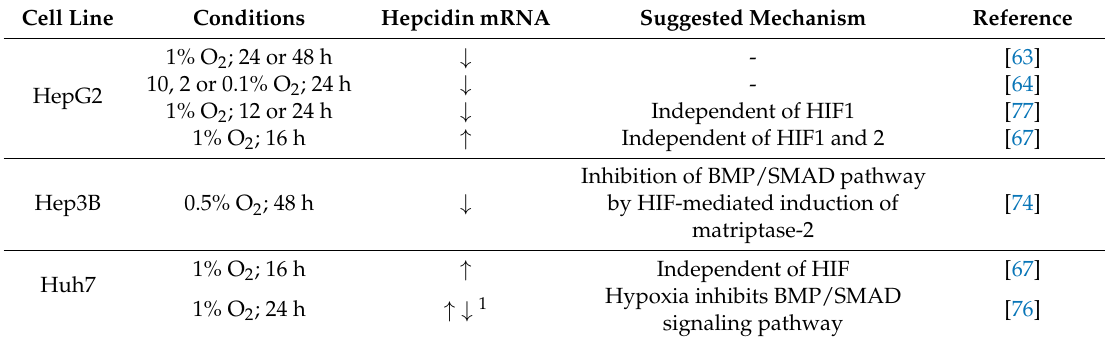
Table 1. Hypoxia-mediated hepcidin regulation in hepatoma cell